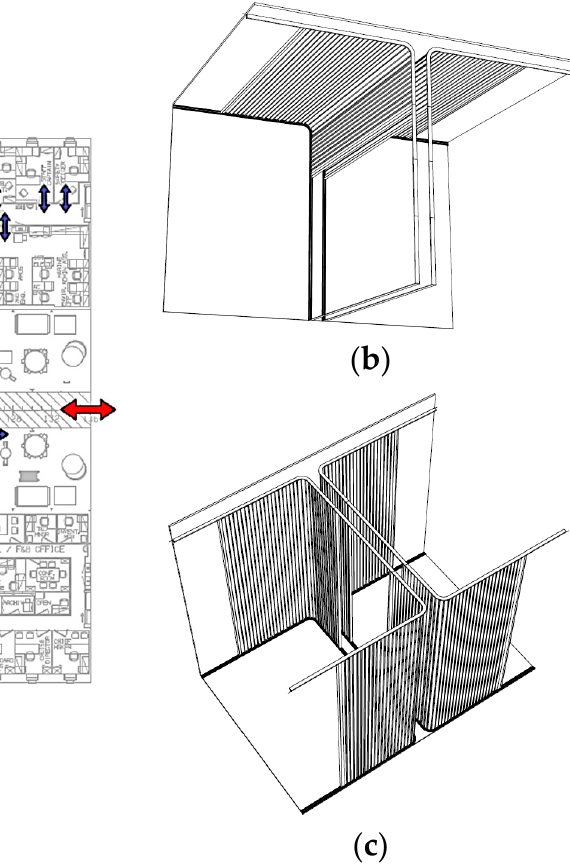
Figure 4. AREST P1 system; ( a ) permanent foam installation sites (blue) in a double hull. ( b ) Existing ship structures in the installation site. ( c ) Void spaces filled with foam.